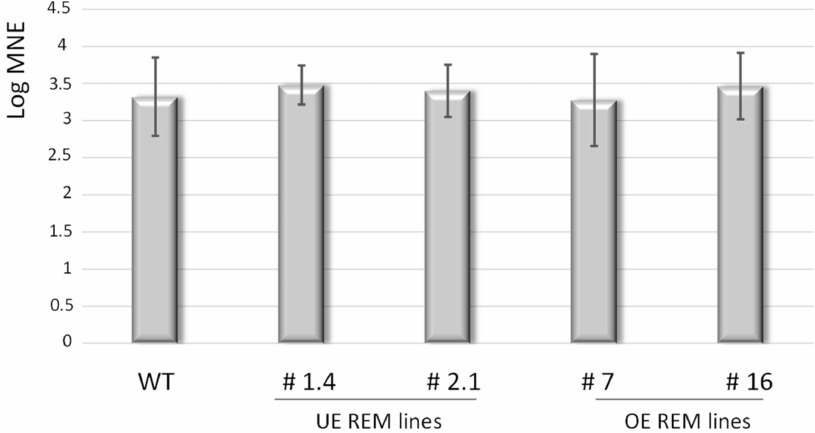
Figure 3. Relative CP gene expression of TuMV w15A (log mean normalised expression, MNE) in the different N. benthamiana lines. TuMV CP gene expression was expressed as log mean normalised expression (MNE) in the different N. benthamiana genotypes at 5 dpi. The CP gene expression was normalised with the reference gene GFP-HDEL . Gene expression was quantified in the inoculated leaves sampled from 5 independent plants in three independent experiments. Three technical replicates were performed for each sample. A Kruskal–Wallis test was performed. No significant difference was observed between the different genotypes (alpha risk = 0.05). WT: N. benthamiana wild type. UE REM lines: N. benthamiana lines underexpressing group 1 endogenous NbREMs. OE REM lines: 35S::GFP–REM1.3 overexpressing transgenic